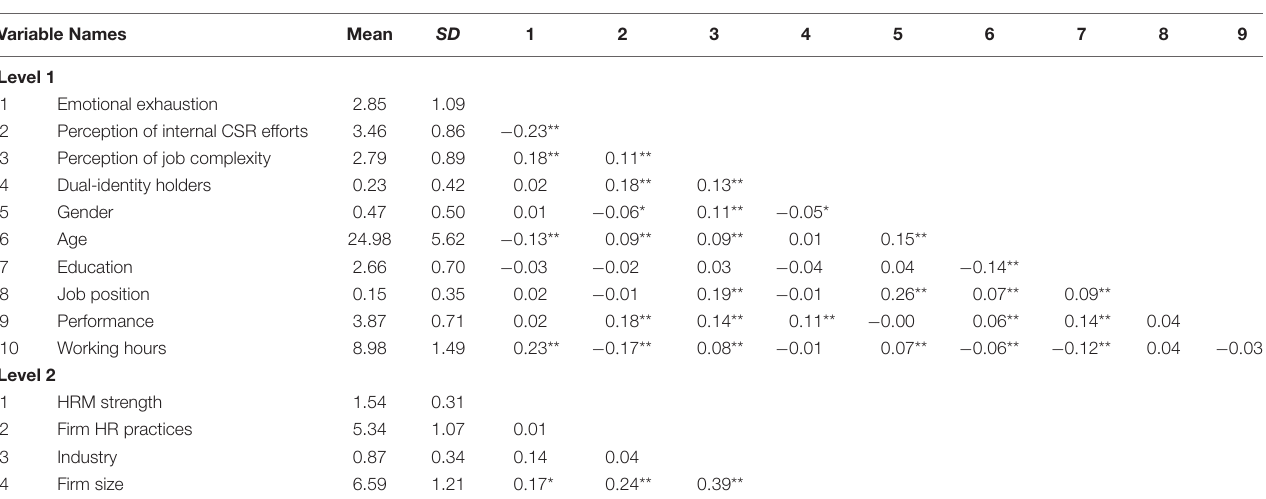
TABLE 1 | Means, standard deviations, and